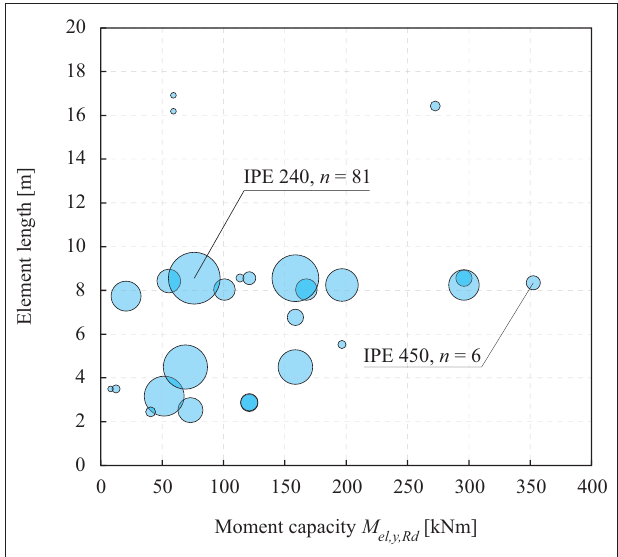
FIGURE 5 | Length vs. moment capacity distribution of available